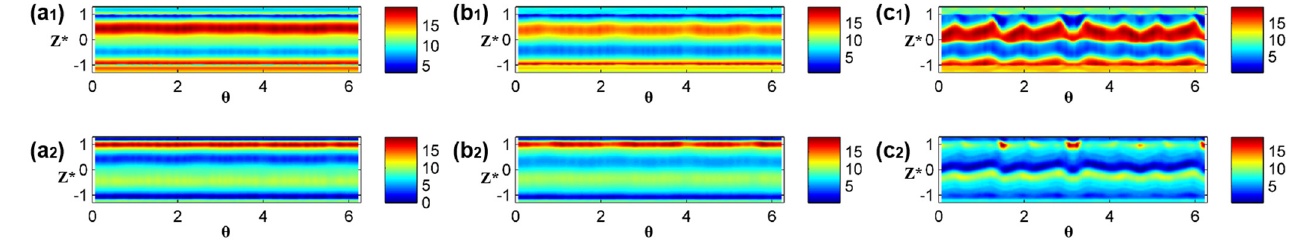
Figure 10. Distribution of the Taylor turbulence at different Re. ( a ) Re = 1.75 × 10 3 ; ( b ) Re = 1.75 × 10 4 ; ( c ) Re = 7.02 × 10 4 .